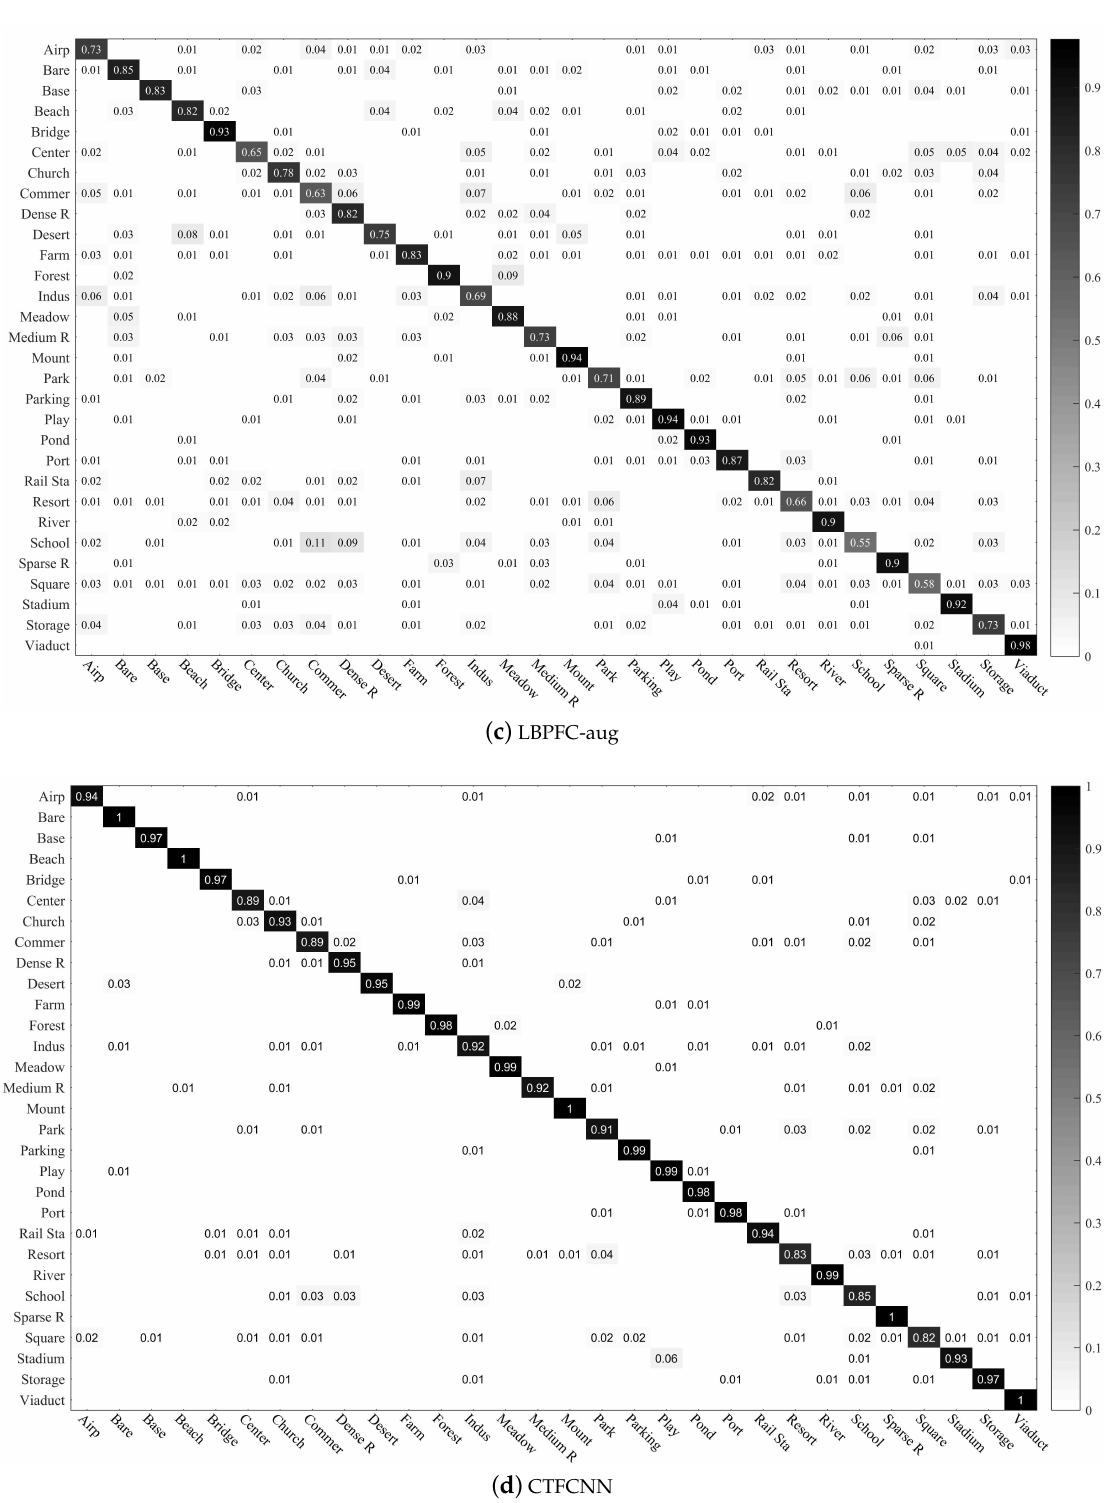
Figure 11. Confusion matrices of CTFCNN for the AID